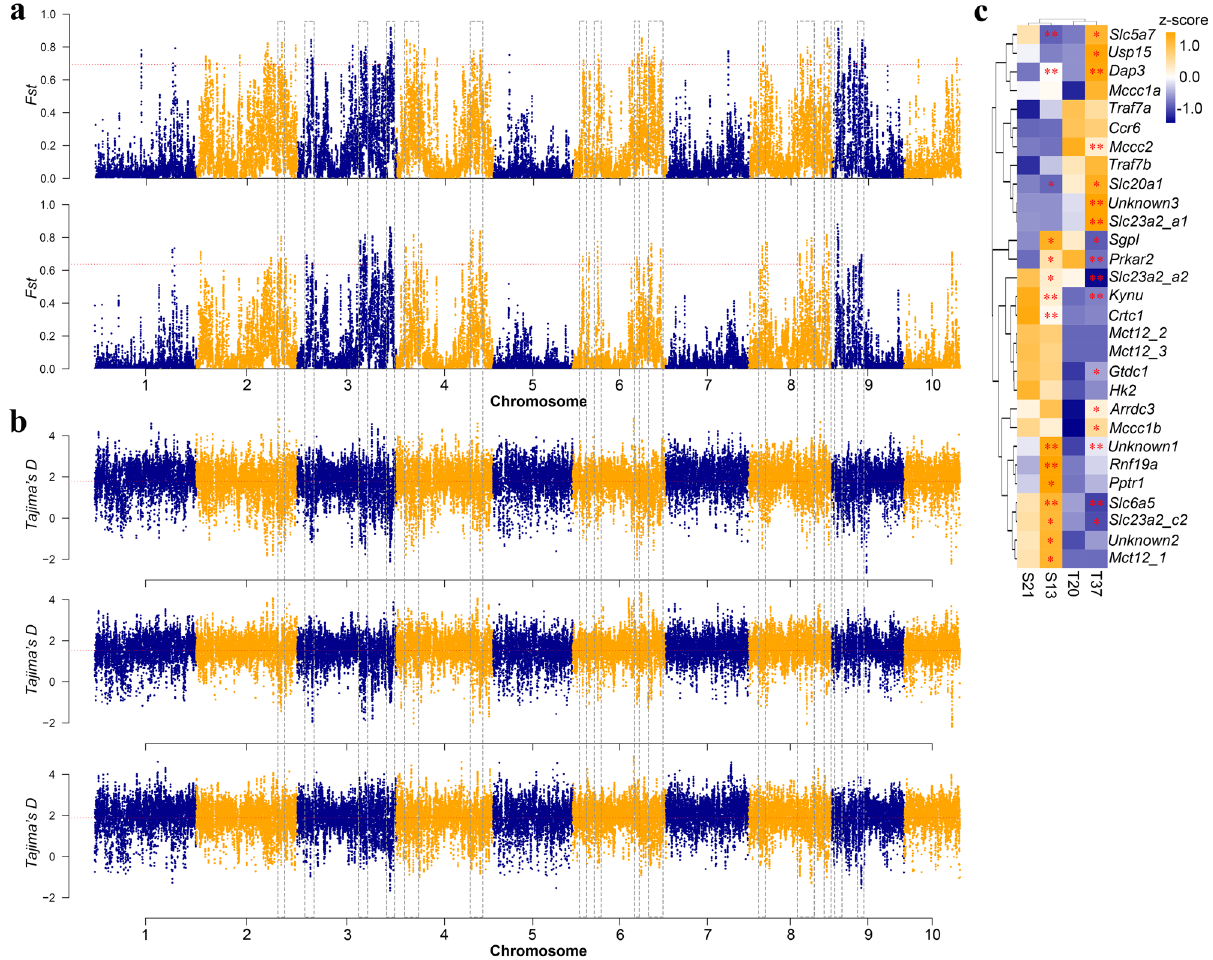
Fig. 4 Genome-wide distribution of selective sweep signals and transcriptional responses of associated genes to thermal and salinity challenges in the estuarine oyster. a Global F ST values (top 1%, red lines) between two population pairs: northern vs. southern (up) and middle vs. southern (bottom). b Global Tajima ’ s D values in northern (up), middle (middle) and southern (bottom) populations. c Expression of genes under selection exposed to thermal (6 h at 37 °C) and high-salinity (7 days at 60 ‰ ) challenges. Asterisks indicate signi fi cant difference (* p < 0.05, ** p < 0.01). The blue-to-yellow color bar represents the relative expression level of the given gene from low to